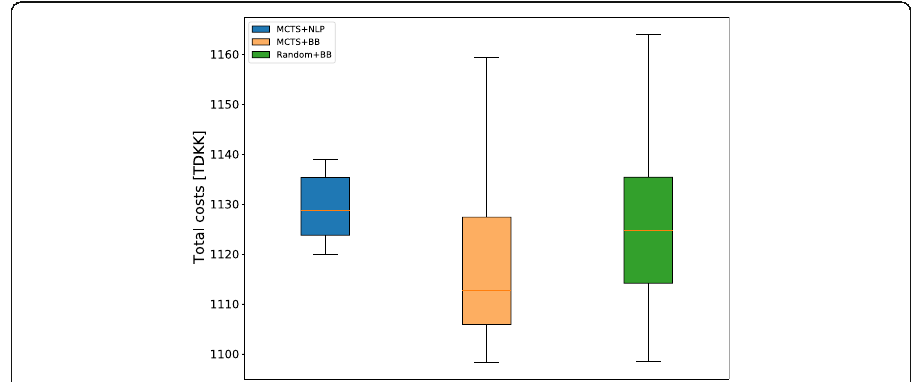
Fig. 10 Boxplot of objective function value for time windows in range 12 to 14. Each boxplot contains 15 samples